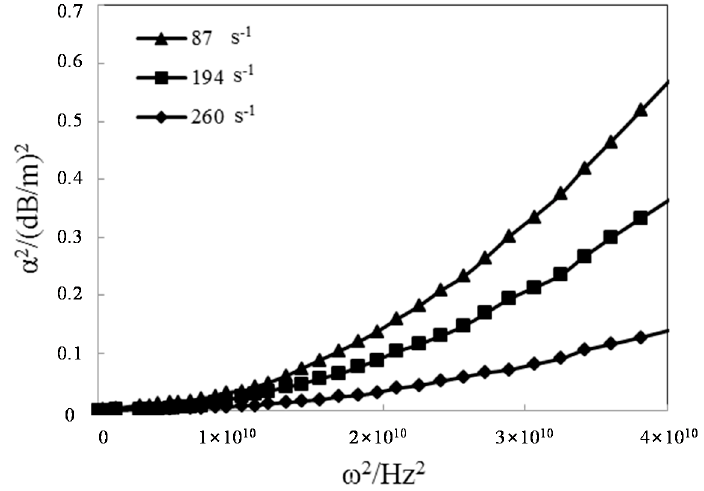
Figure 6. Effects of the stress wave frequency on attenuation factors in viscoelasticity.